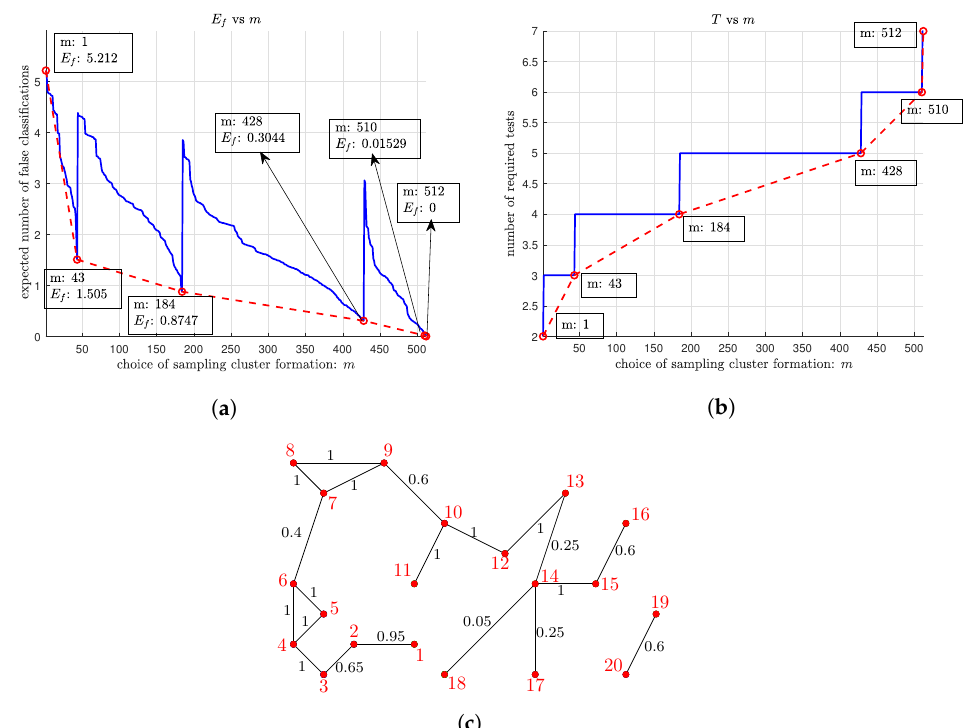
Figure 9. ( a ) Expected number of false classifications vs. the choice of sampling cluster formation F m ; ( b ) required number of tests vs. the choice of sampling cluster formation F m ; ( c ) random connection